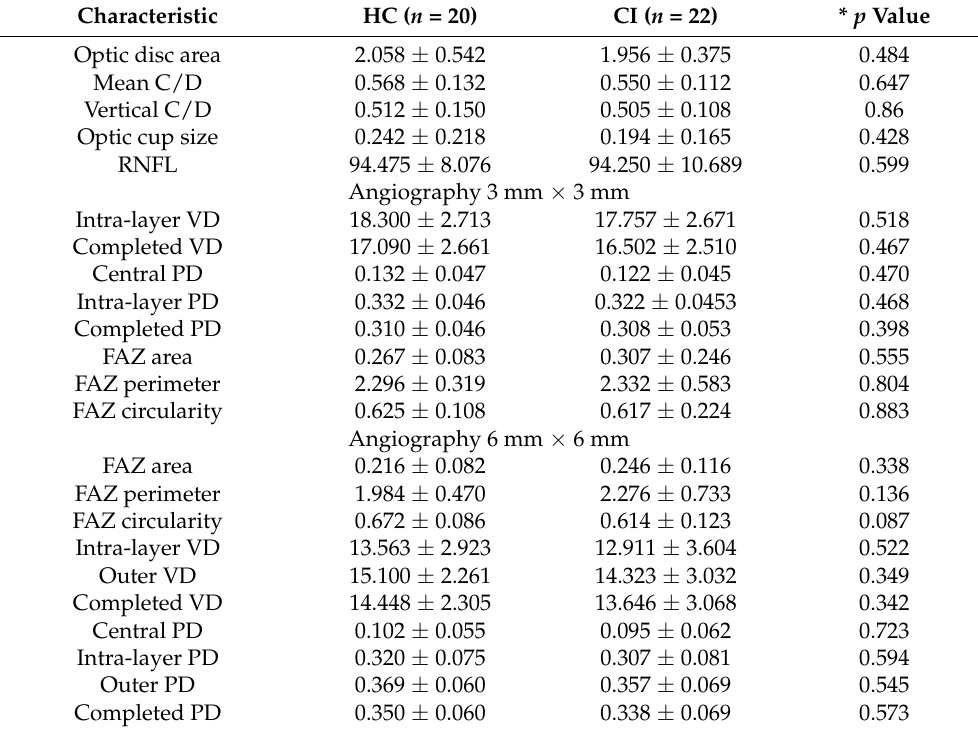
Table 2. Structural changes of the retinal vascular structures between HC and CI subjects. Characteristic HC ( n = 20) CI ( n = 22) * p Value Optic disc